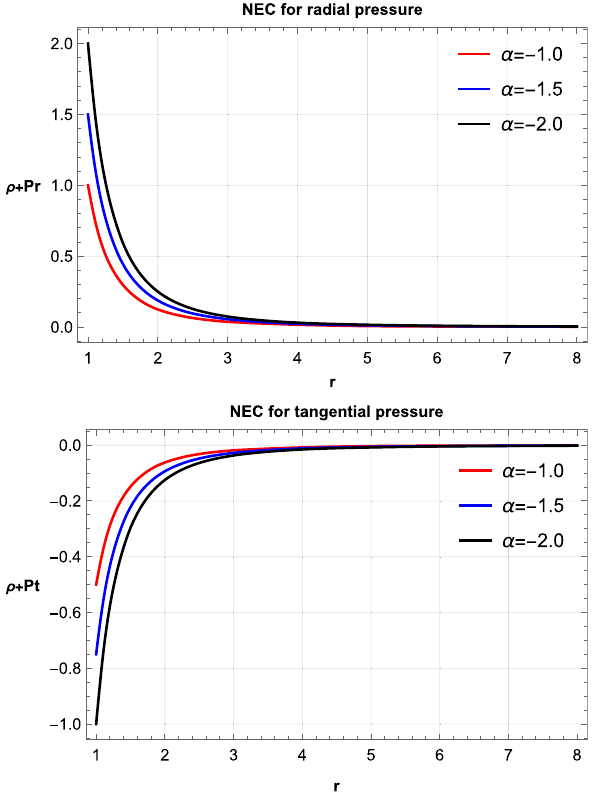
Fig. 16 The variation of DEC against r for two sphere (case-2) with r 0 = 1 and D = 20